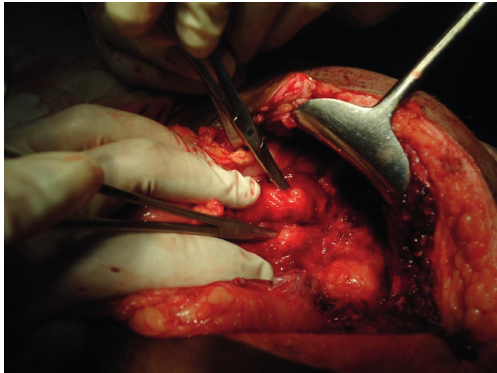
Figure 3: Two small bowel perforations being demonstrated by